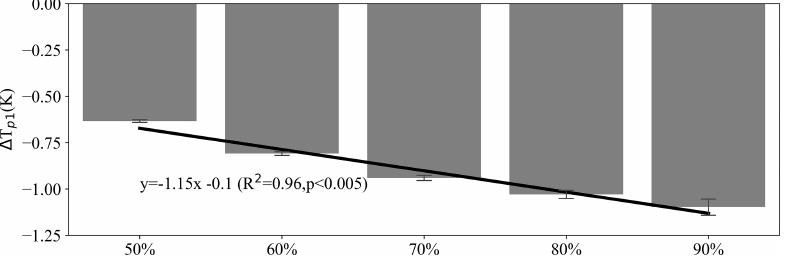
Figure A6. The influence of the forest-cover threshold applied to the land-cover map underlying the estimation of the mixed potential effect ( (cid:49)T p ). 1